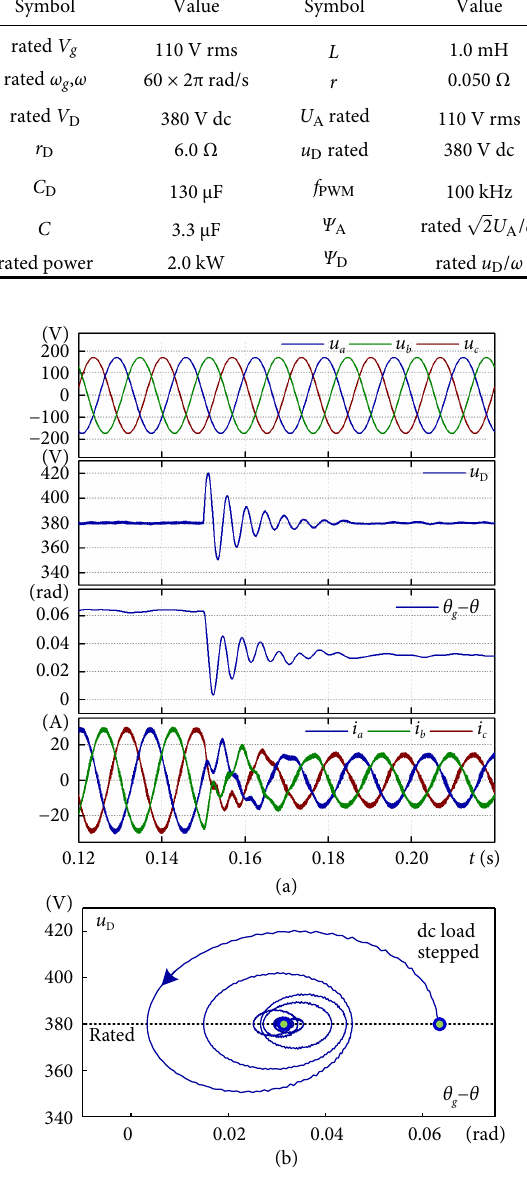
Fig. 6 The self-synchronization of the VSSM mechanism in load step response: (a) waveform in time domain, (b) plane